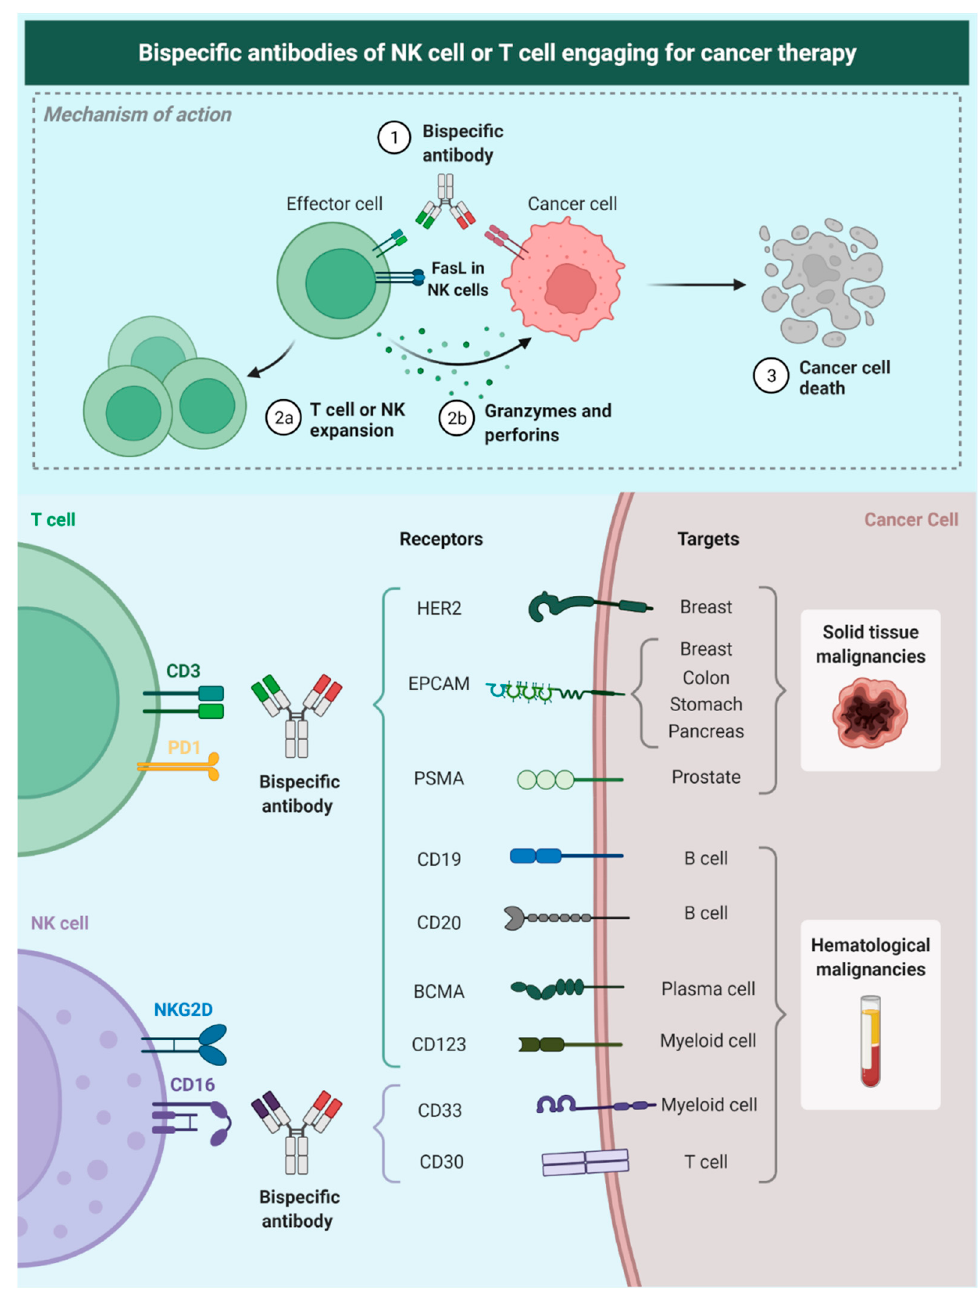
Figure 2. Description of the mechanism of NK-Bias; these antibodies target a tumor-related antigen and bind membrane receptors on NK cells allowing a spatial and molecular immune-mediated cell-killing process. We also show some of the tumor-associated targets that currently have been studied for therapy. Epithelial cell adhesion molecule (EpCAM), epidermal growth factor receptor 2 (HER2), prostate specific membrane antigen (PSMA), B-cell maturation antigen (BCMA), CD19, CD20, CD123, CD33, CD30 (cluster of differentiation [CD]).